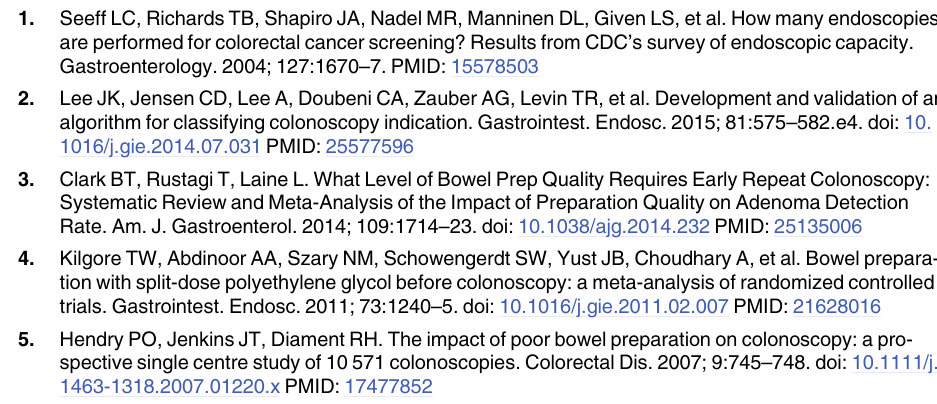
S2 Table. Scores for Modified Downs and Black Scale for full-text studies included in review. S3 Table. Study descriptions for non-full text studies. S4 Table. Assessment of risk of bias in non-full text studies. S5 Table. Summary of primaryoutcomes for non-full text studies by preparation